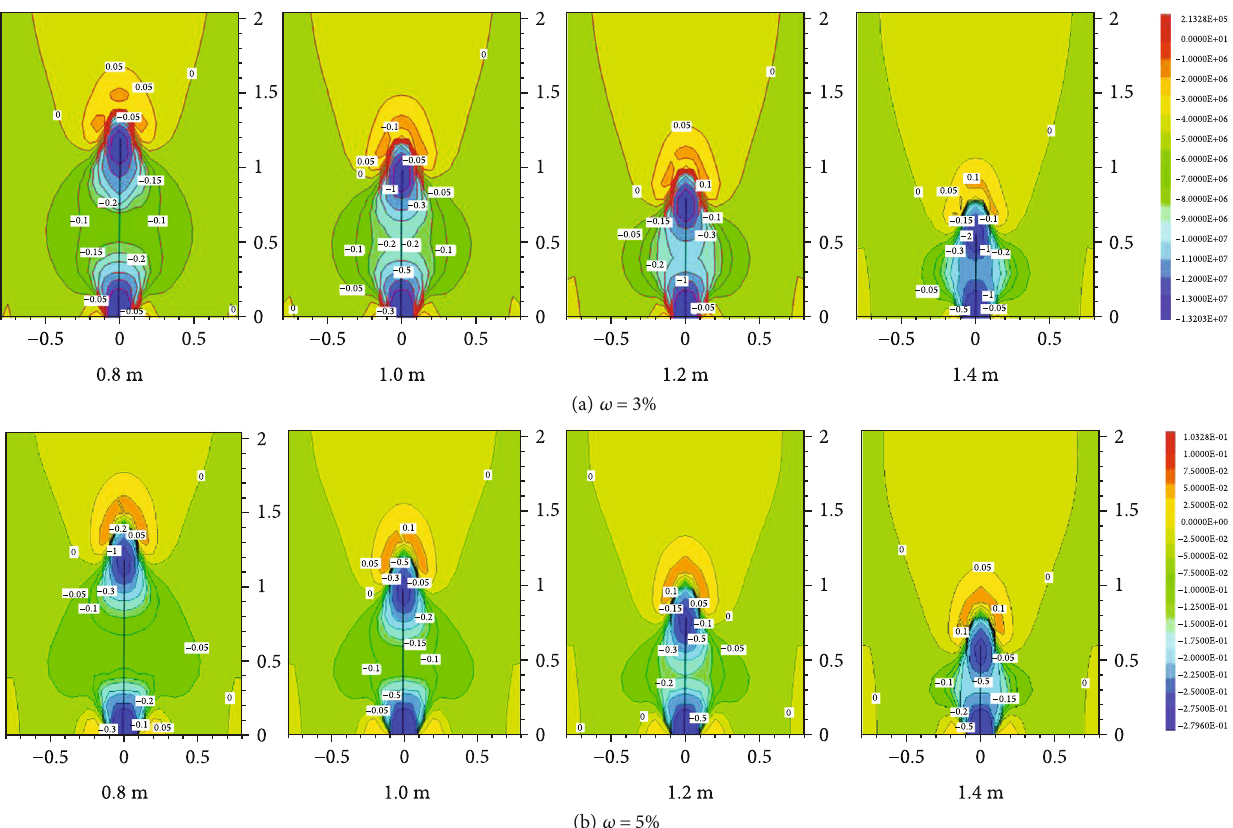
Figure 11: Supporting stress contour in di ff erent anchorage